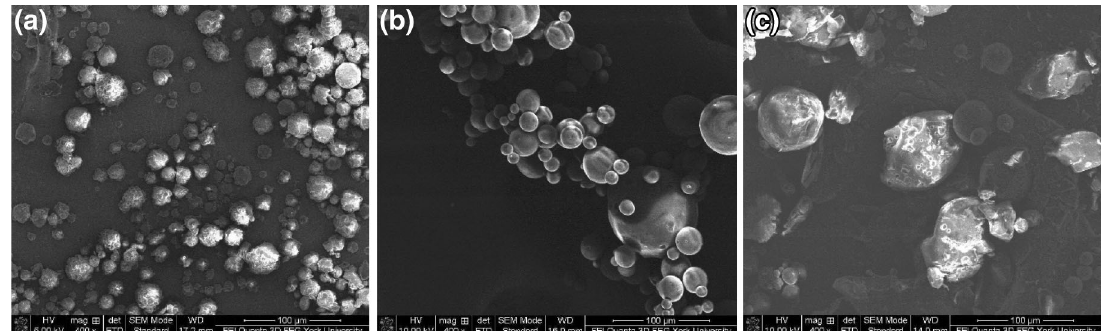
Fig. 7 SEM micrographs of PLA–PA microPCM fabricated by different material compositions: a PCM0.6 PVA3 ; b PCM0.6 SDS3 ; and c PCM0.6 SDS0.5